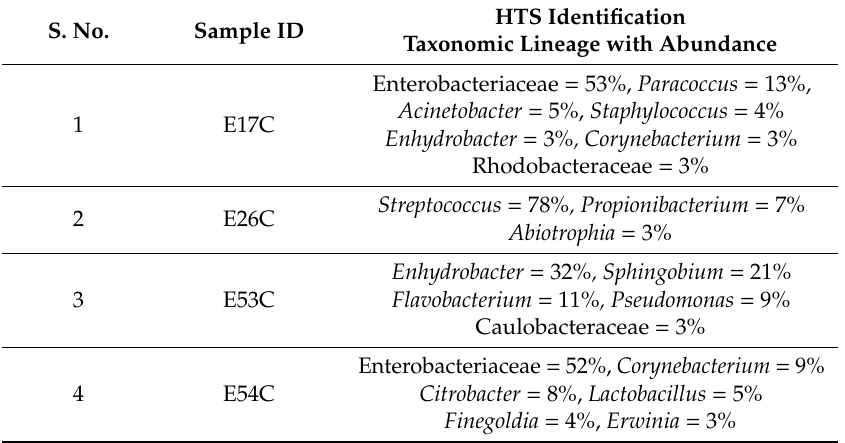
Table 4. HTS reads and taxonomic lineage identified in control